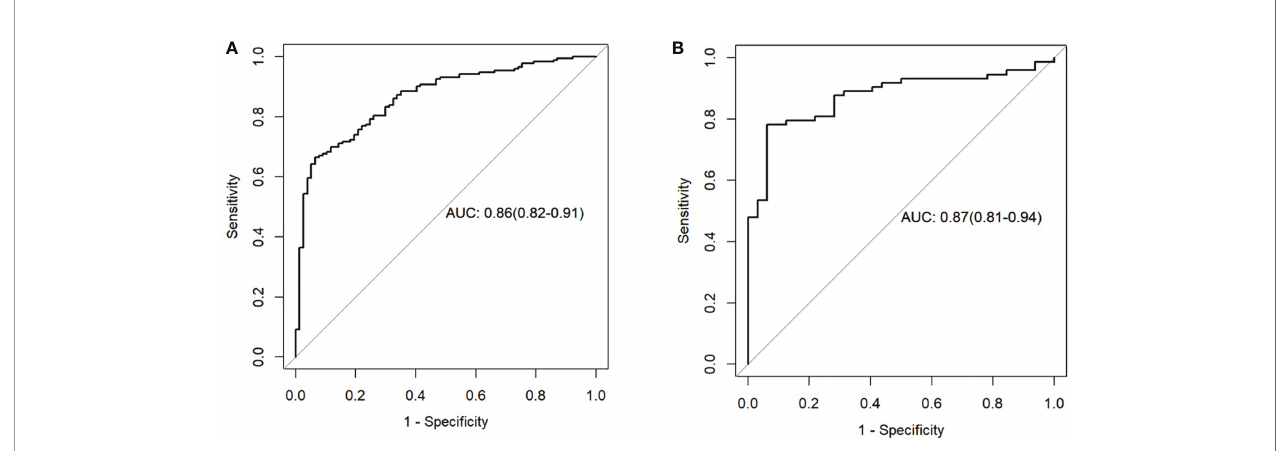
FIGURE 5 | Receiver operating characteristic (ROC) curves of the radiomics model in the training set (A) and testing set (B)